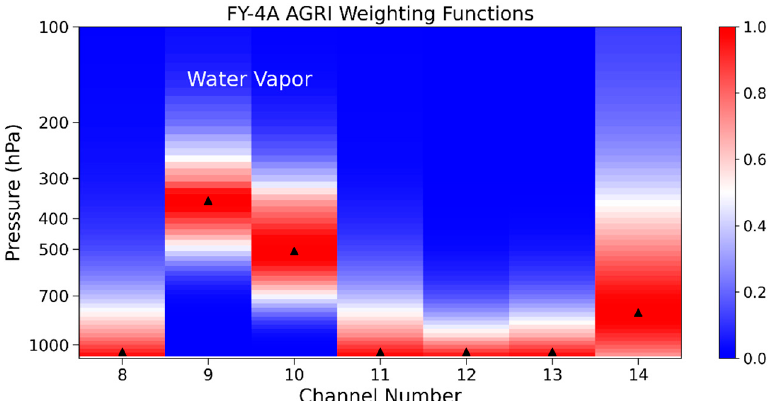
Figure 1. Normalized weighting functions (WFs) of the FY-4A AGRI channels 8–14. The black triangles stand for the WF peak levels.